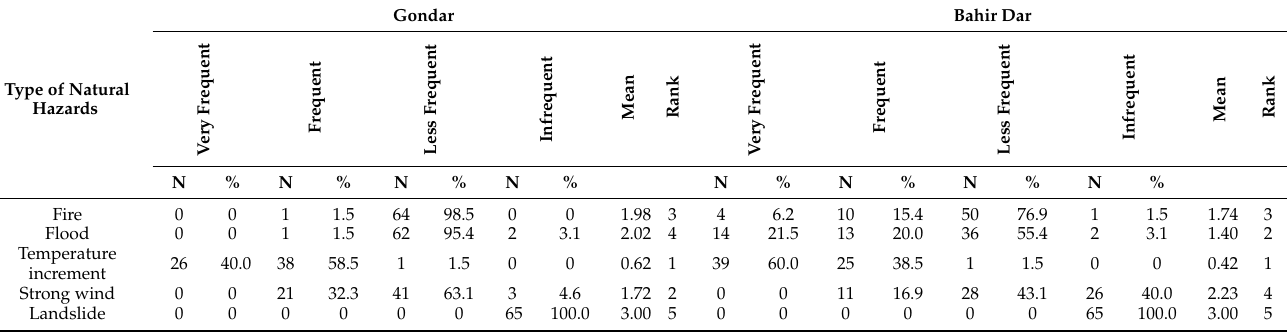
Table 4. Frequency and rank of hazards in the study